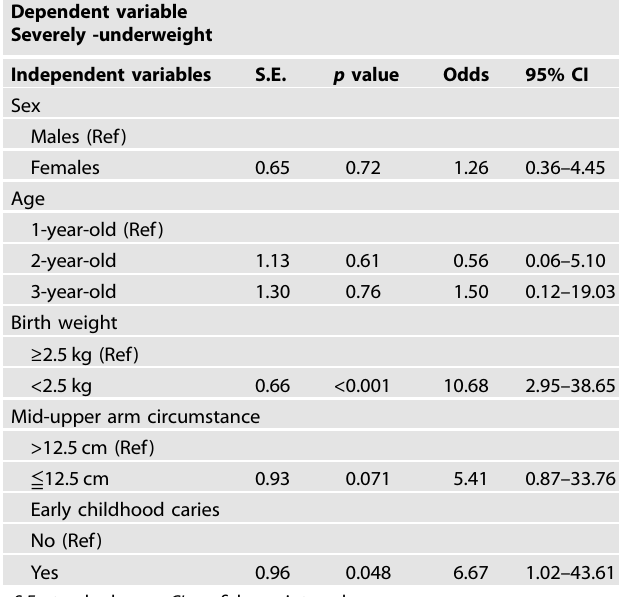
Table 3. Logistic regression analysis on severely -underweight among young children ( n =